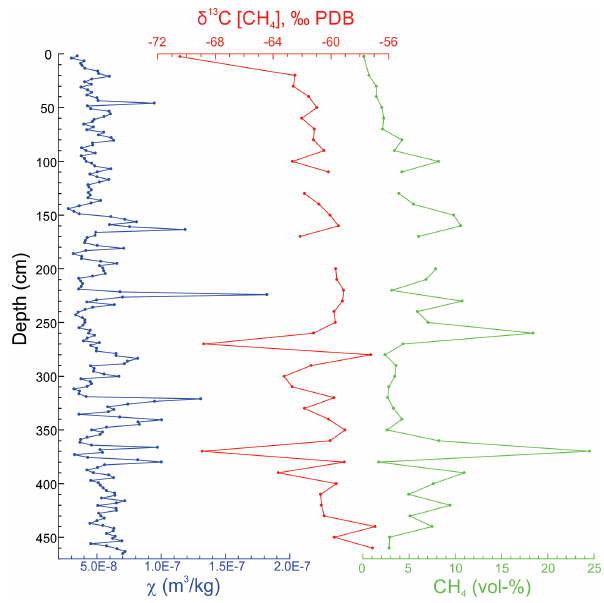
Figure 6. Low-field magnetic susceptibility by mass normalized of sediments and concentration CH 4 (vol-%) and stable carbon iso- topes δ 13 C [CH 4 ]‰ PDB in pore waters of XC05 sediment core. Data plotted as a function of